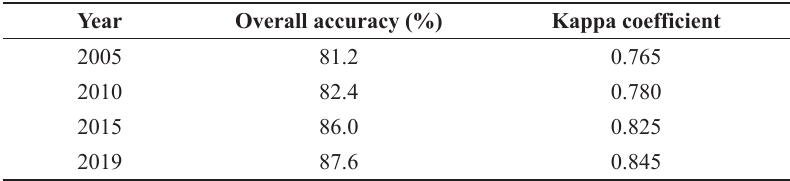
Table 2: Overall accuracy and Kappa coefficients of the classified images.